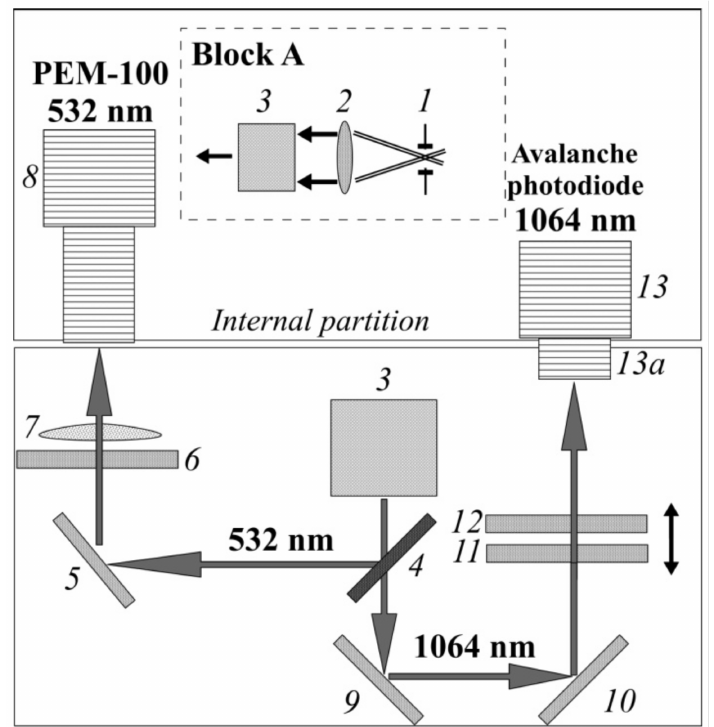
Figure 1. Optical scheme of the two-channel analyzer of the receiving unit. Block A is a block for transmitting a beam from a telescope: 1—the aperture of the field of view; 2—collimating lens; 3— rotary mirror; 4—spectral splitter, 532-1064 nm. Channel 532 nm: 5—dielectric mirror;